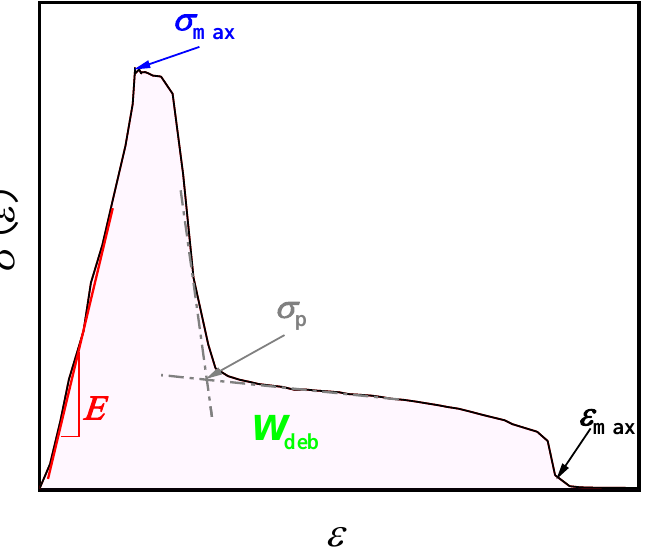
Figure 2. Schematic stress – strain curve obtained during probe-tack experiments illustrating the characteristic parameters extracted from the test (see text).